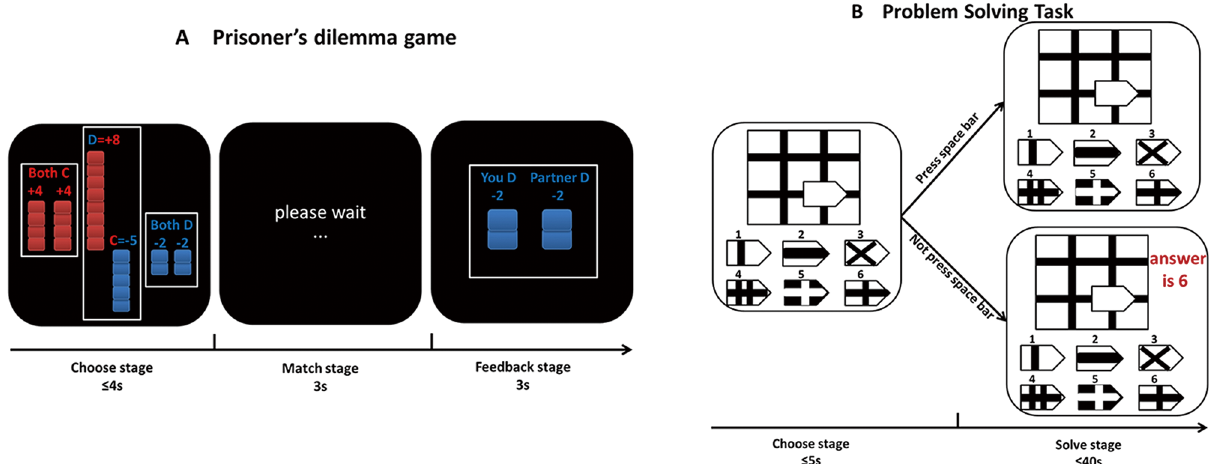
Fig 1. The experimental tasks. (A). The prisoner ’ dilemma game. In the prisoner ’ s dilemma game, +8 points to the defector and -5 points to the cooperator when one player defected (D) and the other cooperated (C); +4 points to each player when both players cooperated (C); -2 points to each player when both defected (D). At the beginning of each trial, an asterisk was presented first on the screen for 2s to engage focus and eye fixation. Then the payoff matrix was shown at the center of the screen for 4s, during which participants decided to defect or cooperate, and after that, there was 3s for matching stage. Then feedback was shown for 2s. The player ’ s choice was presented on the left and the partner ’ s choice was presented on the right. As participants would earn ¥ 0.2 per point, they were told to try to earn as many points as they could for themselves regardless of others. Participants were informed that they were playing with a same sex partner in another room. (B). The problem solving task. At the beginning of each trial, an asterisk was presented first on the screen for 2s to engage focus and eye fixation. On each trial, when problems were presented, the correct answer would appear on the screen unless they stopped it from being shown by pressing the space bar within 5s after the question appeared. Then participants had 40 seconds to answer each question. The task began with four examples so that participants could familiarize themselves with the